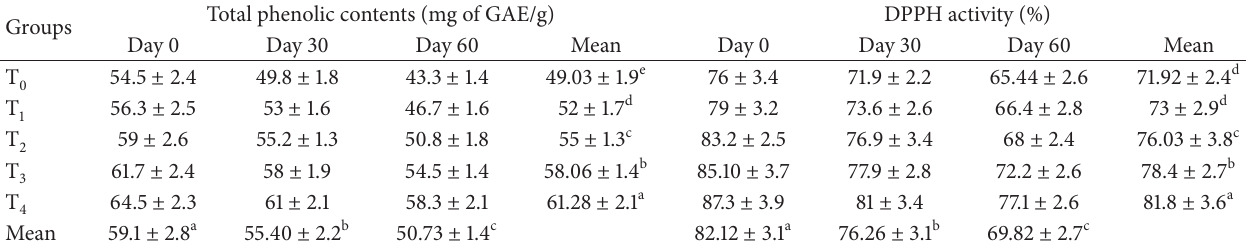
Table 1: Effect of different groups on total phenolic contents (mg of GAE/g) and DPPH (%) activity in thigh meat. Total phenolic contents (mg of Groups